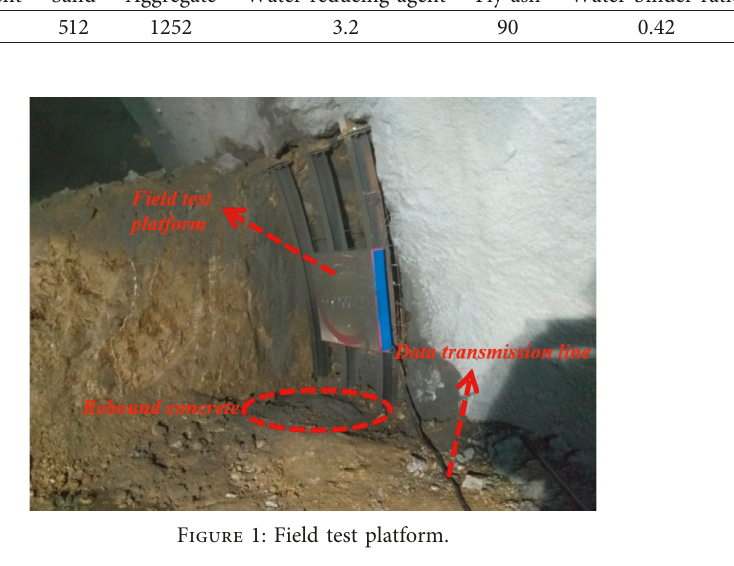
Figure 1: Field test platform.